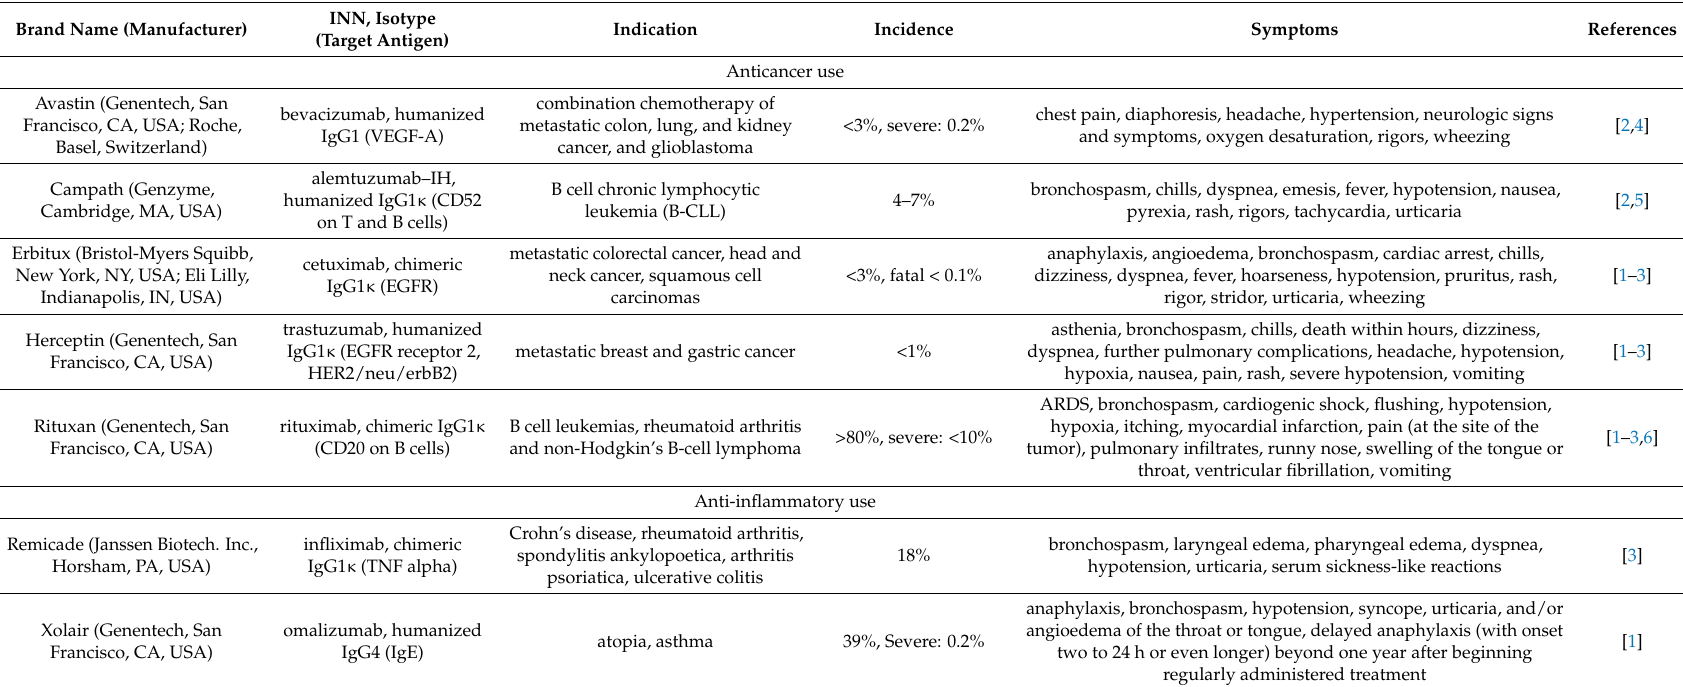
Table 1. Information on hypersensitivity reactions to marketed monoclonal